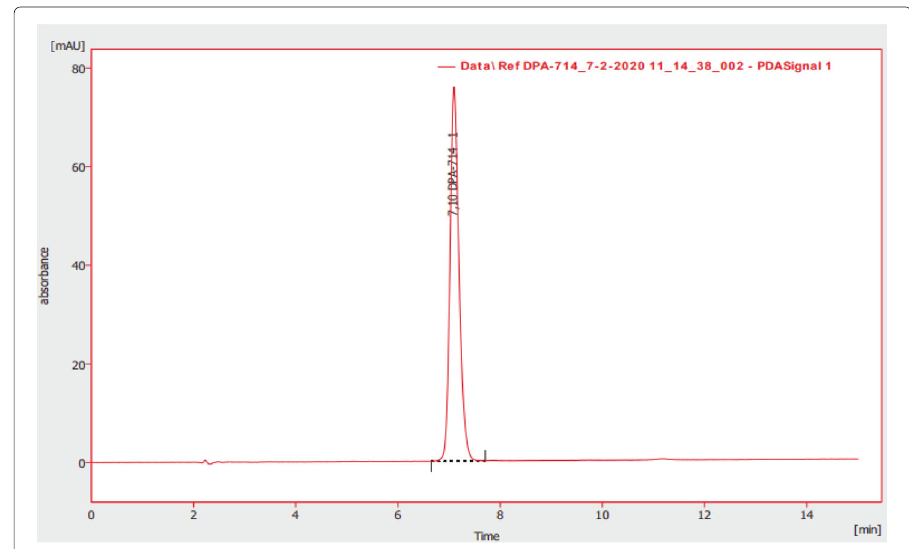
Fig. 5 Typical HPLC chromatogram ( λ = 254 nm) obtained with a DPA-714 reference standard (10 μg/mL)